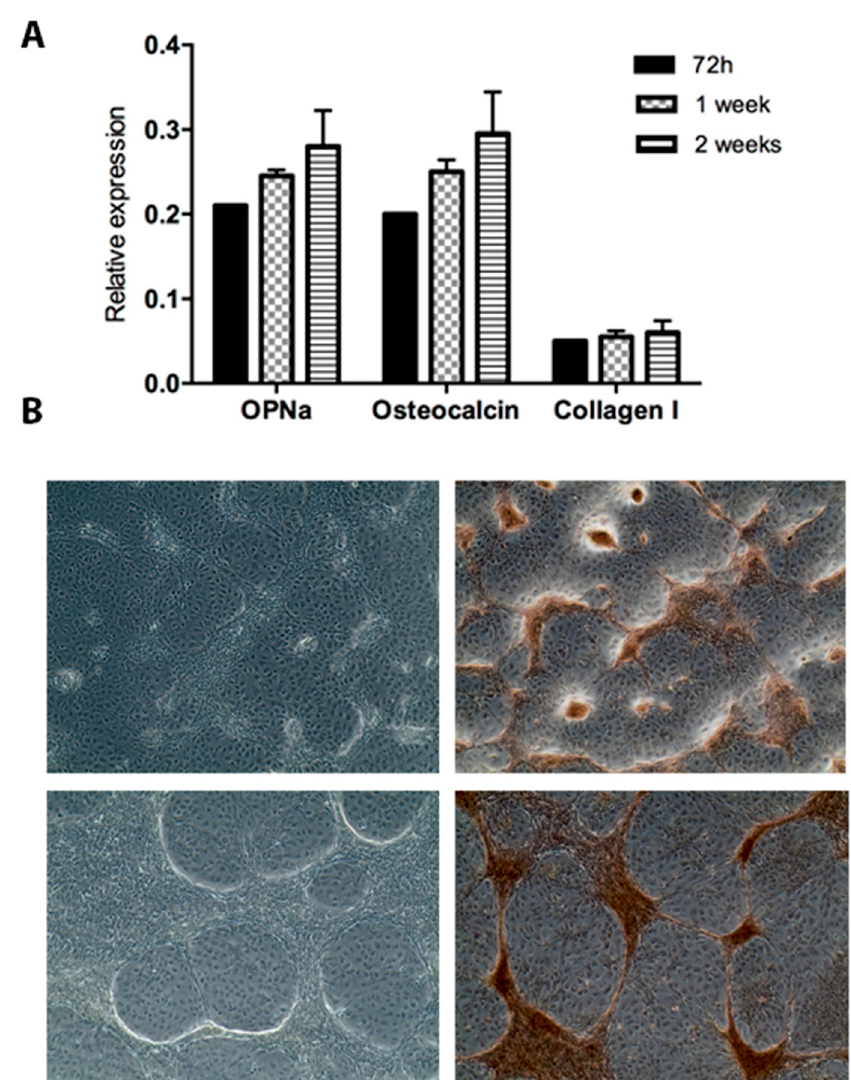
Figure 3. OPNa, osteocalcin, and collagen type I transcript levels and calcification deposits in TPC-1 cell line. ( A ) OPNa, osteocalcin, and collagen type I messenger RNA (mRNA) expression levels was measured by RT-qPCR in the TPC-1 thyroid cell line after 72 h, 1 week, and 2 weeks of cell culture. ( B ) Representative phase contrast images for 72 h ( upper panel ) and 1 week ( lower panel ) of cell culture of TPC-1 cell line are shown in the left column. In the right column, matrix calcification was detected with Alizarin Red staining after 72 h and 1 week of cell culture. Dark brown areas correspond to ECM rich in calcium deposits.